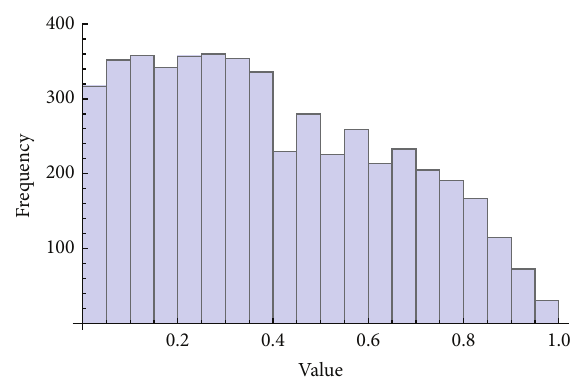
Figure 9: Histogram of the distribution of real numbers transferred into the range ⟨0 - 1⟩ generated by means of the chaotic Lozi map, 5000 samples.